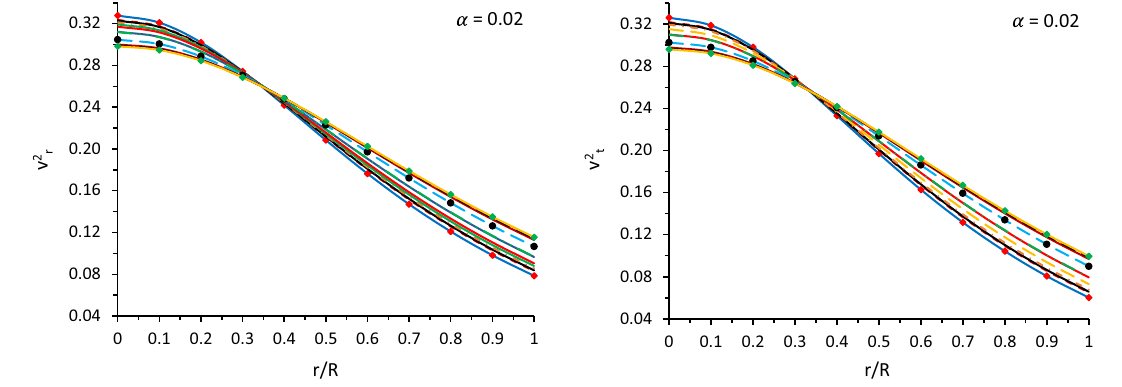
Fig. 9 The behavior of radial velocity ( v 2 r ) and tangential velocity ( v 2 t ) versus radial coordinate r / R by taking the numerical values of the constants a = 0 . 003, b = 0 . 0000053, β = 1 . 1, and γ = − 0 . 001